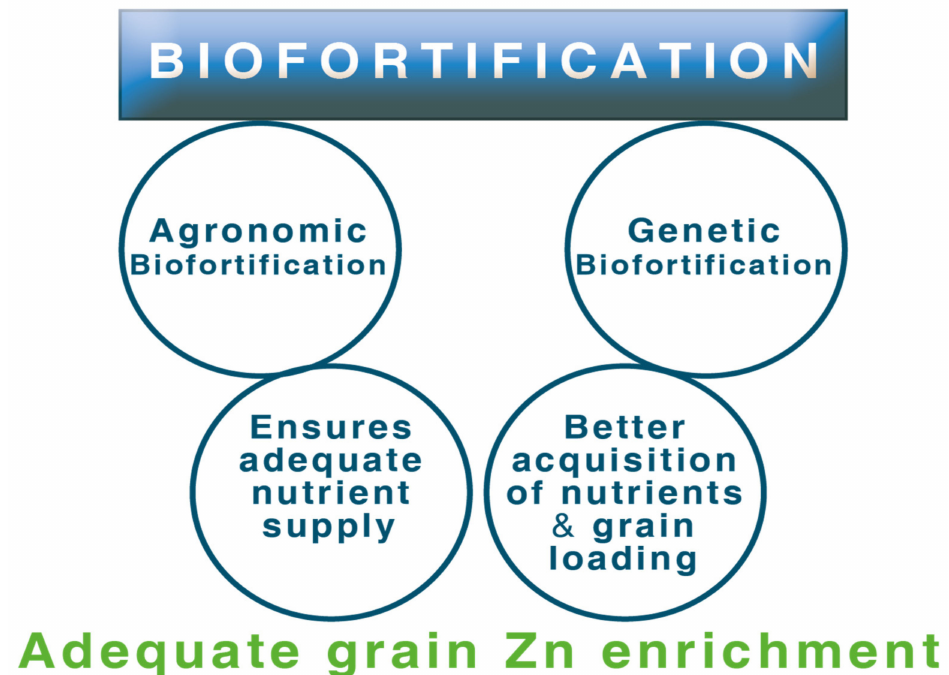
Figure 3. Complimentary effect of agronomic and genetic